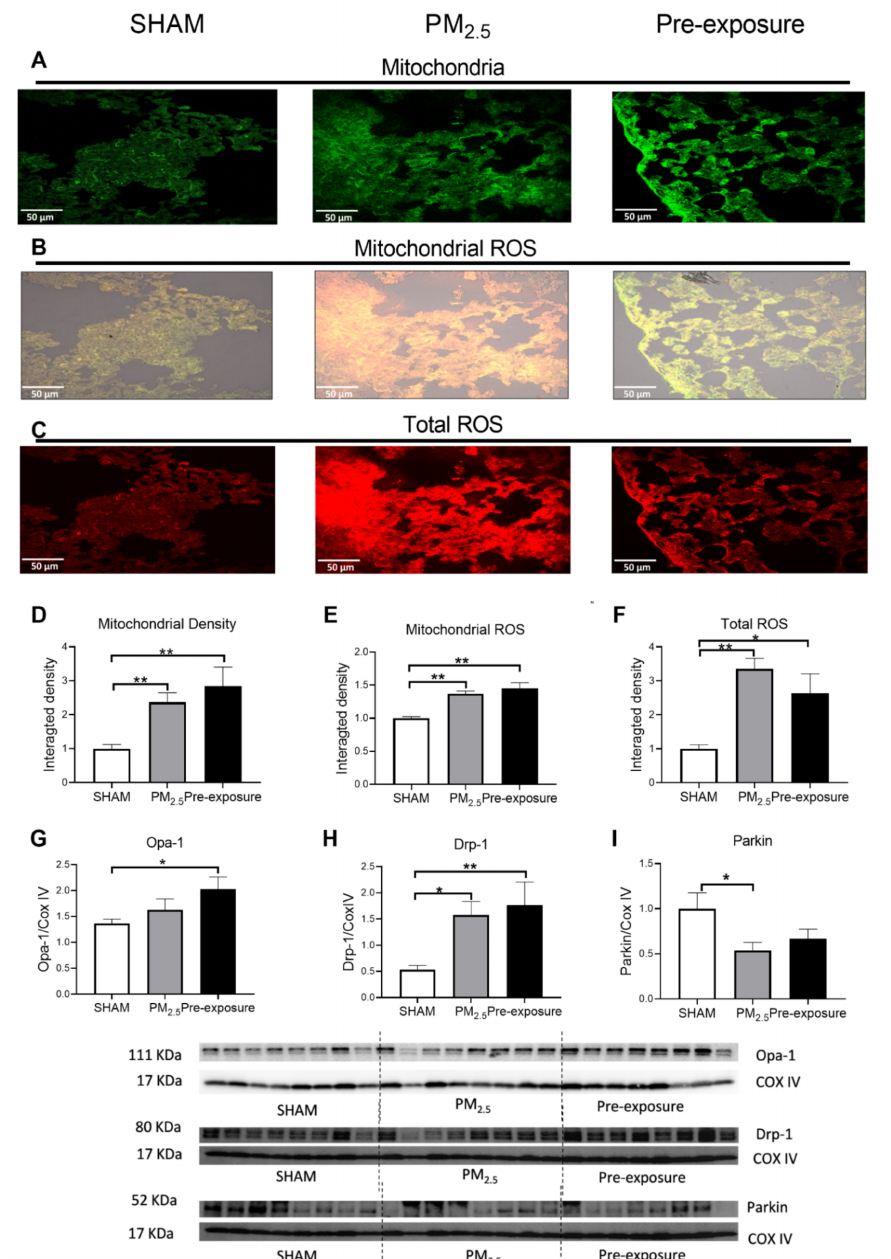
Figure 6. Maternal PM 2.5 exposure changed mitochondrial density and ROS level in the female offspring at 13 weeks. Representative images of ( A ) mitochondria (green), ( B ) mitochondrial specific ROS (orange) and ( C ) total ROS staining (red), and ( D – F ) quantitative results. Protein levels of ( G ) Opa-1, ( H ) Drp-1 and ( I ) Parkin. Data were analysed by one-way ANOVA followed by Fisher’s LSD post hoc tests. * p < 0.05, ** p < 0.01, n = 5 in mitochondrial fluorescence staining, n = 8 in Western blot. Drp-1, dynamin-related protein; Opa-1, optic atrophy-1; PM 2.5 : dams exposed to PM 2.5 (5 µ g/day) prior to mating for 6 weeks during gestation and lactation. Pre-exposure: dams exposed to PM 2.5 for 6 weeks prior to